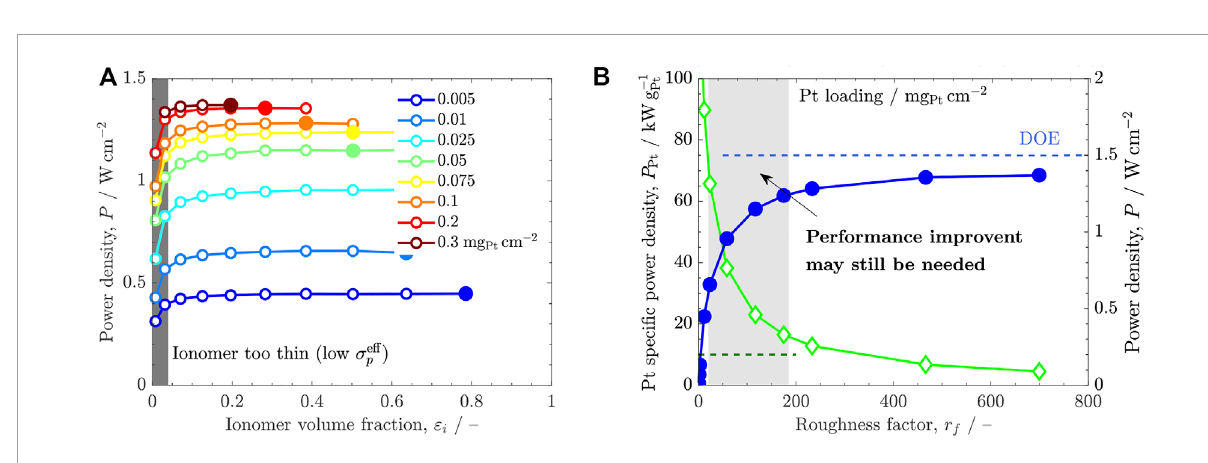
FIGURE 8 (A) Variation of the geometric power density, P , with the ionomer volume fraction, ɛ i , at the design point of minimum transport resistance corresponding to several Pt loadings, L Pt = 0.005 − 0.3 mg Pt cm −2 . The power density is reduced when ɛ i is small because of the drop of σ eff p (bottleneck effect caused by too thin ionomer pillars). The computed optimal ionomer volume fractions are highlighted by big solid dots. (B) Variation of the Pt mass-specific power density and geometric power density ( V cell = 0 . 5 V), P Pt and P , respectively, with the roughness factor, r f , at the optimal CL design point. The corresponding Pt loading is shown on the top axis, L Pt = r f δ Pt ρ Pt ; δ Pt = 0 . 2 nm. The DOE power density target at rated power (1 W cm −2 @ 0.76 V, T = 80 ° C) has been extrapolated to the examined voltage (1.5 W cm −2 @ 0.5 V) (DOE,